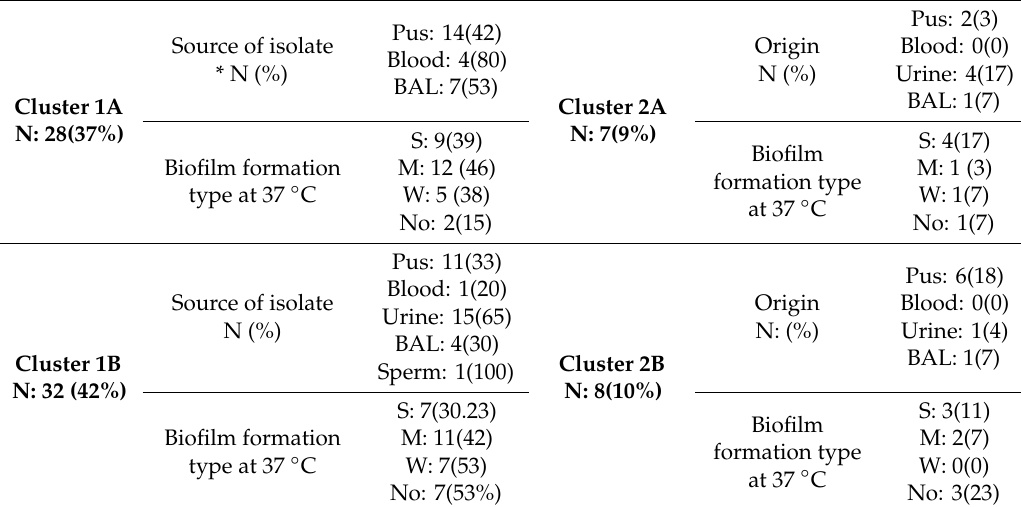
Figure 6. Relationship between PSA Isolates. Bacterial designations are based on sample origin and biofilm formation ability. Table 4. PSA designations based on sampling origin and biofilm formation ability. The table was generated using data on the